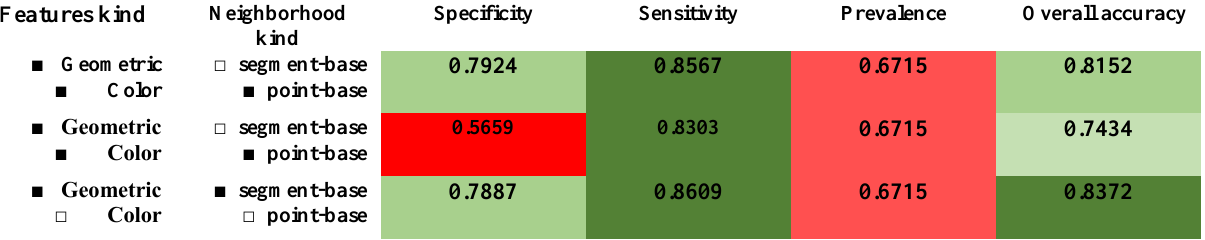
As Table 2, Sensitivity, specificity and overall accuracy are used for classification evaluation. Sensitivity, specificity and accuracy are described in terms of TP, TN, FN and